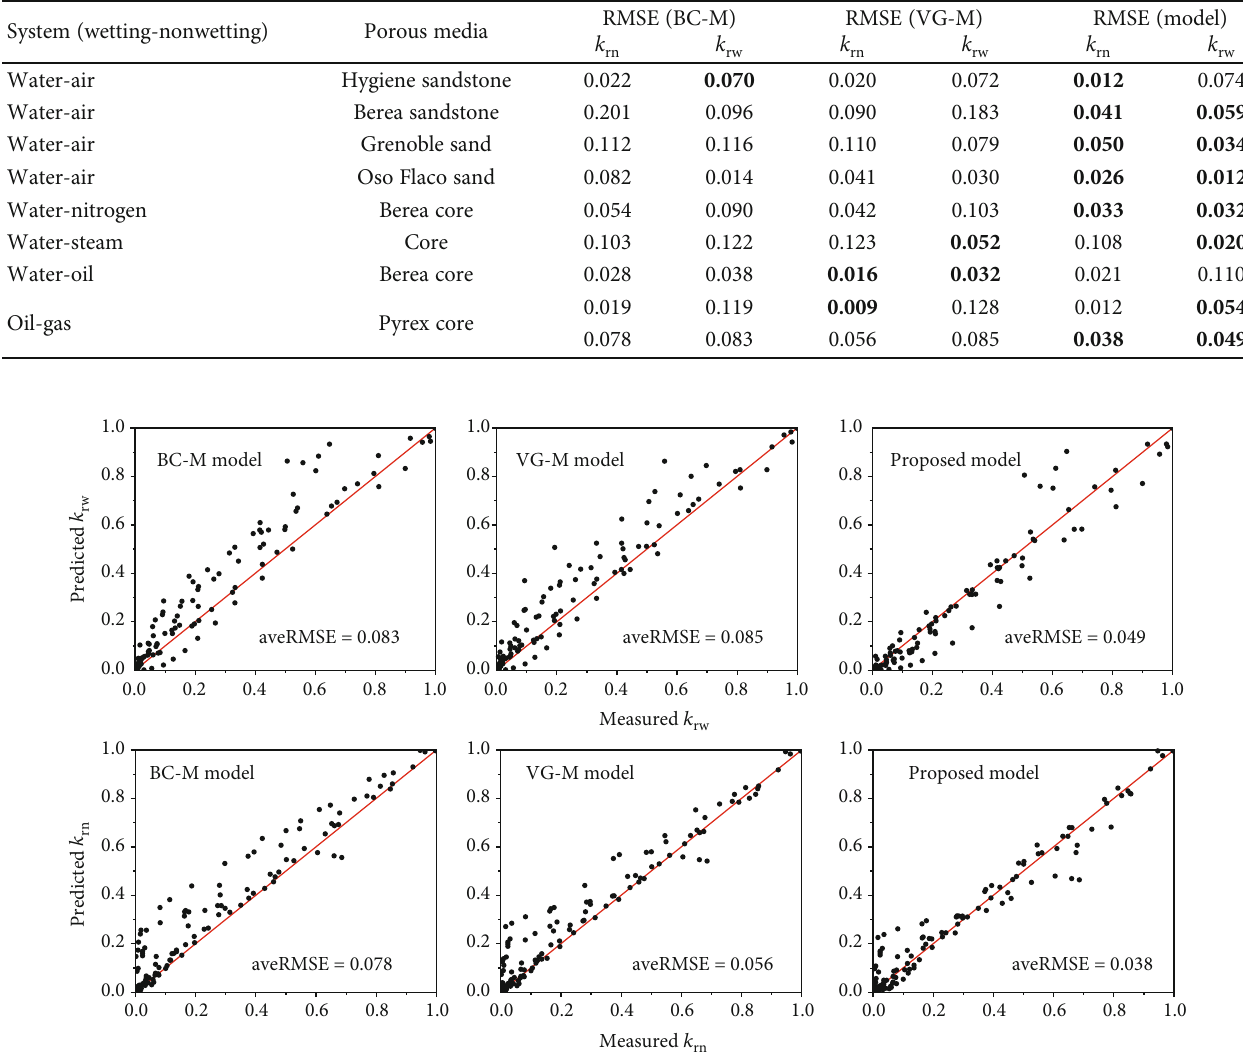
Figure 7: Scatter plot of measured versus predicted values for BC-M, VG-M, and the proposed